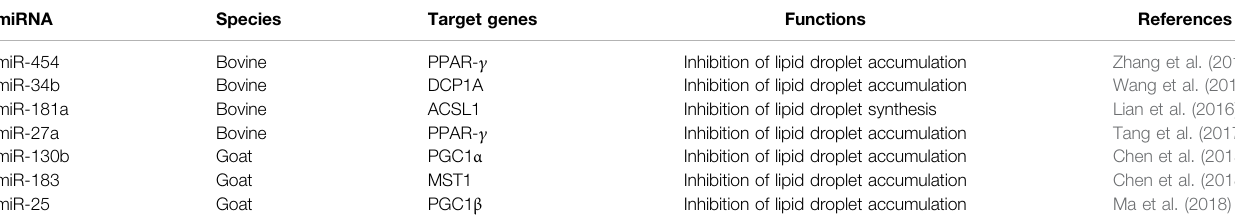
TABLE 2 | miRNAs involved in the regulation of lipid droplet synthesis and accumulation in ruminant. miRNA